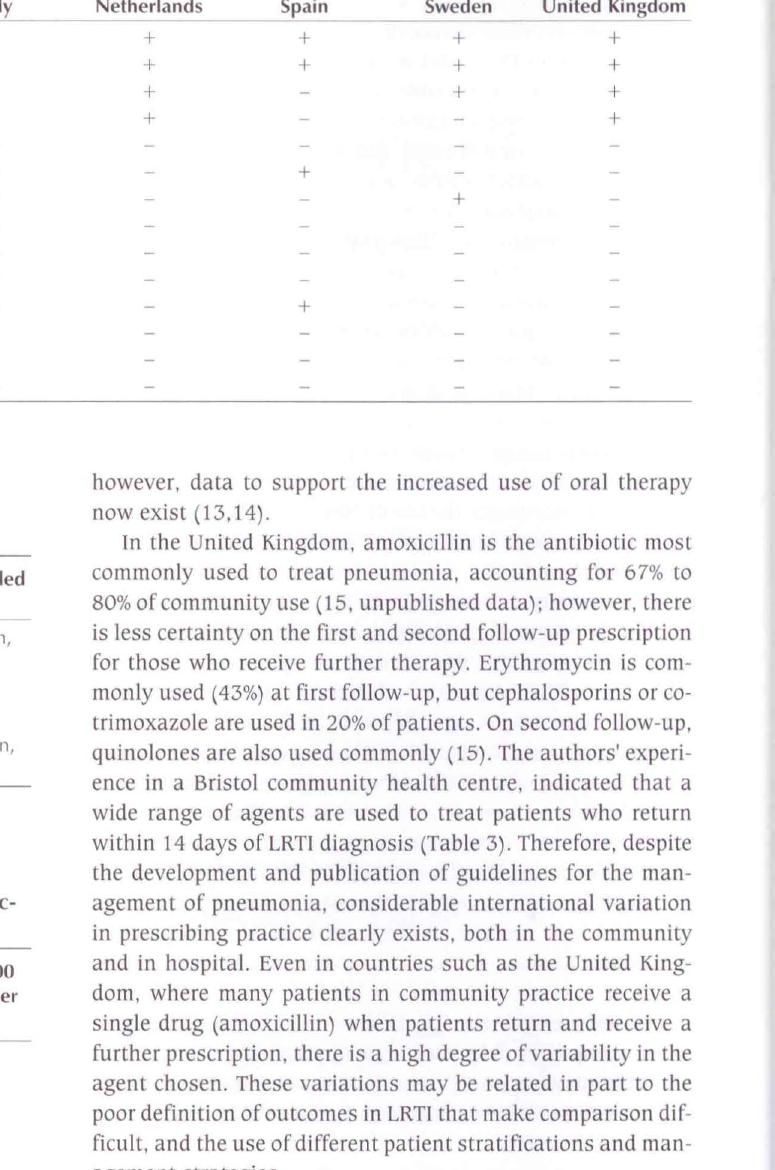
Hospital admissions, duration of stay and hospital cost re lated with age in patients with lower respiratory tract